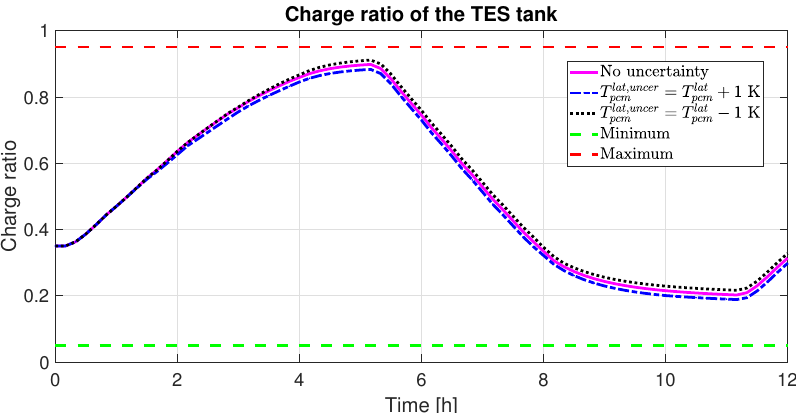
Figure 17. Charge ratio of the TES tank when some prediction model uncertainty is